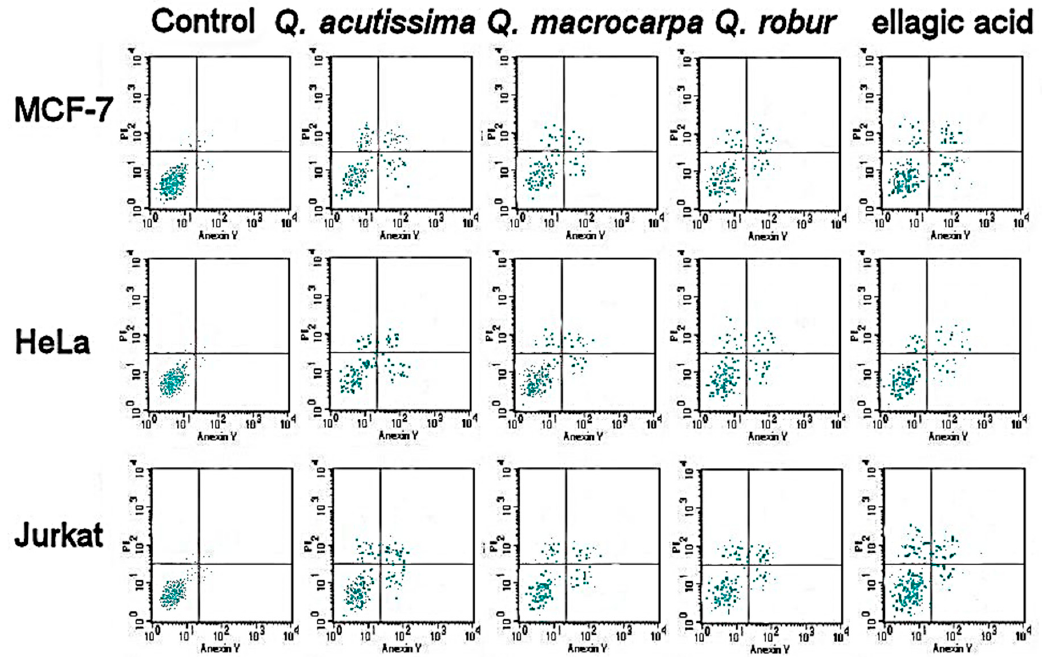
Figure 2. Apoptotic cell population (IC 30 ) using flow cytometry.